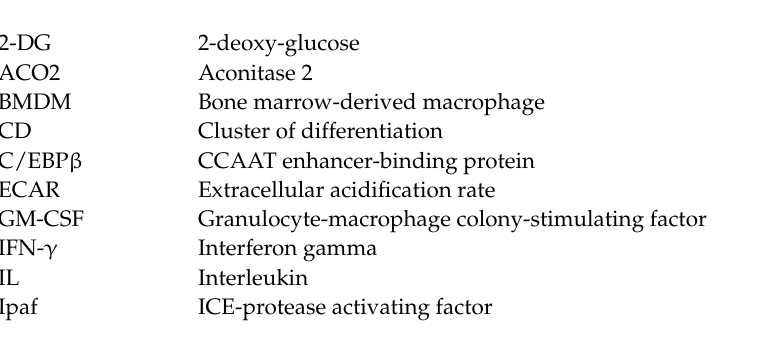
Figure S2: Activation of BMDM metabolism is accompanied by both pro- and anti-inflammatory cytokine secretion, Figure S3: The amount of LPS contained within the used rFlaA:Betv1 preparations do not induce BMDM activation, Figure S4: The used rFlaA:Betv1 preparation does not have mTLR2- or mTLR4-activating potential, Figure S5: Both rFlaA + rBet v 1 and rFlaA:Betv1 comparably reduce mitochondrial respiration, Figure S6: Toxicity of the tested inhibitors on C57BL/6 BMDMs, Figure S7: 96 h post-stimulation, rapamycin has only minor effects on rFlaA:Betv1-induced activation of BMDM metabolism and cytokine secretion, Figure S8: rFlaA:Betv1 induces a transcriptional shift towards both increased glycolytic metabolism and higher activation status in